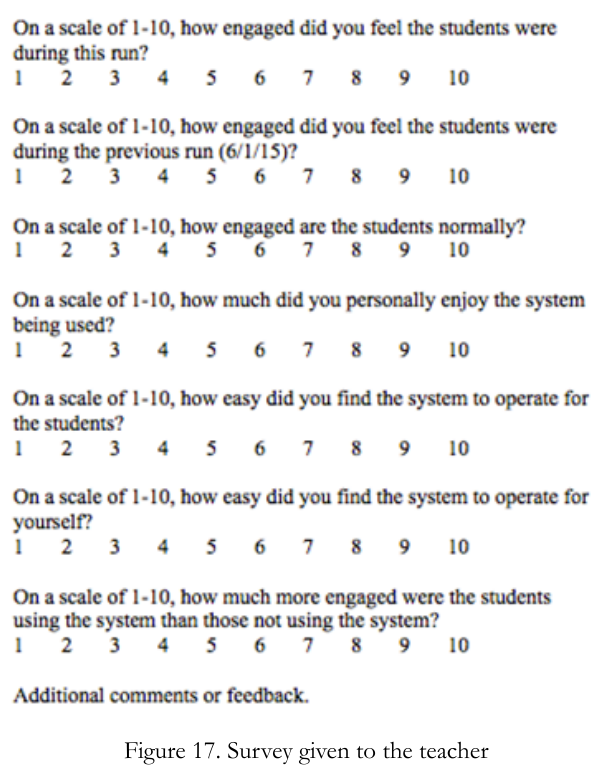
Figure 17. Survey given to the